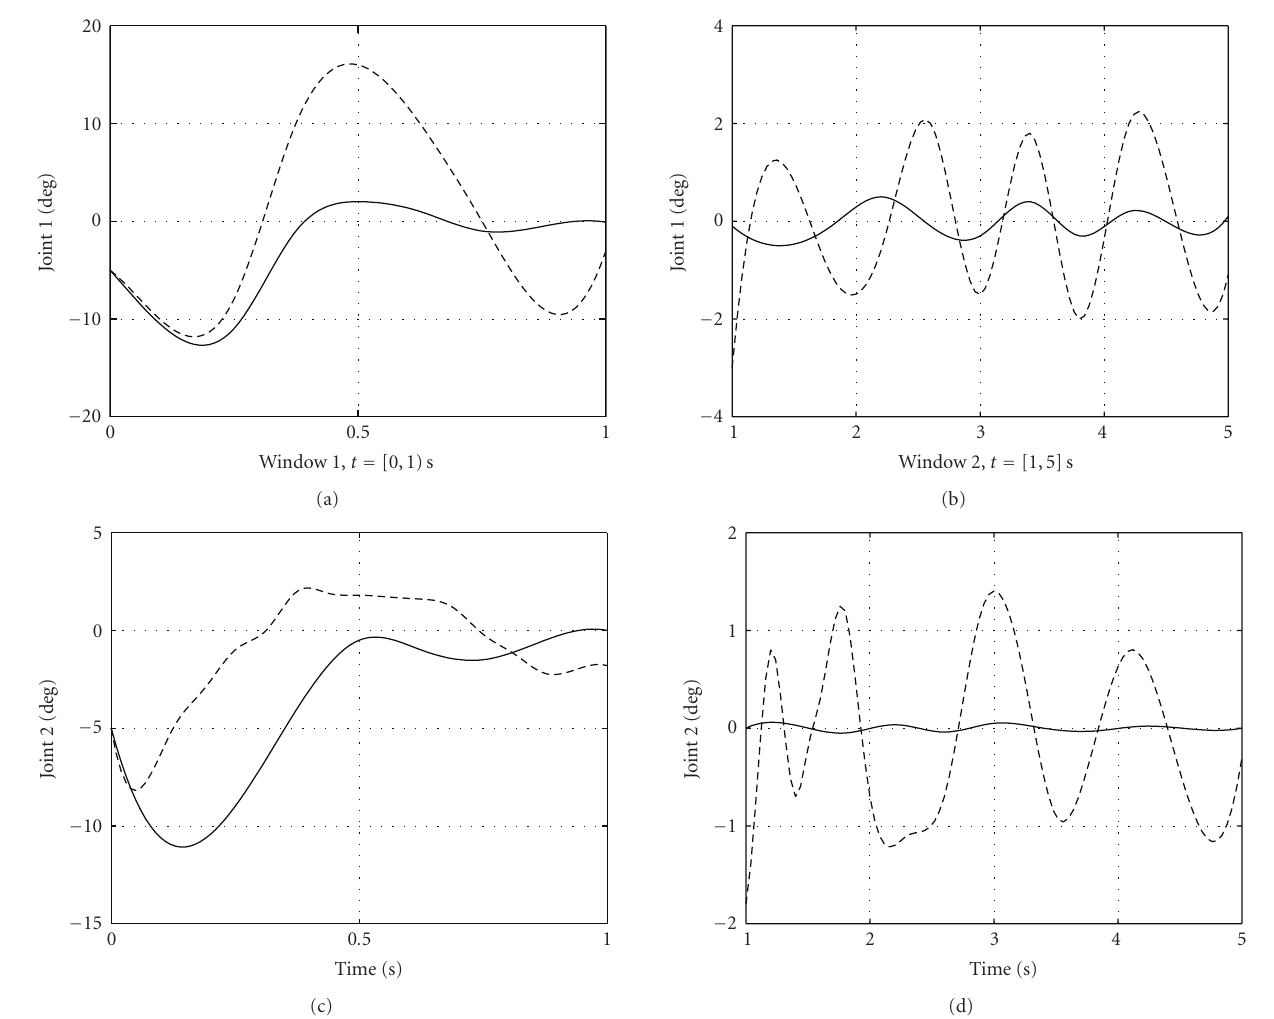
Figure 7: Comparative plots for tracking errors of both joints between the controller [12] (.–) and our proposed controller (–).